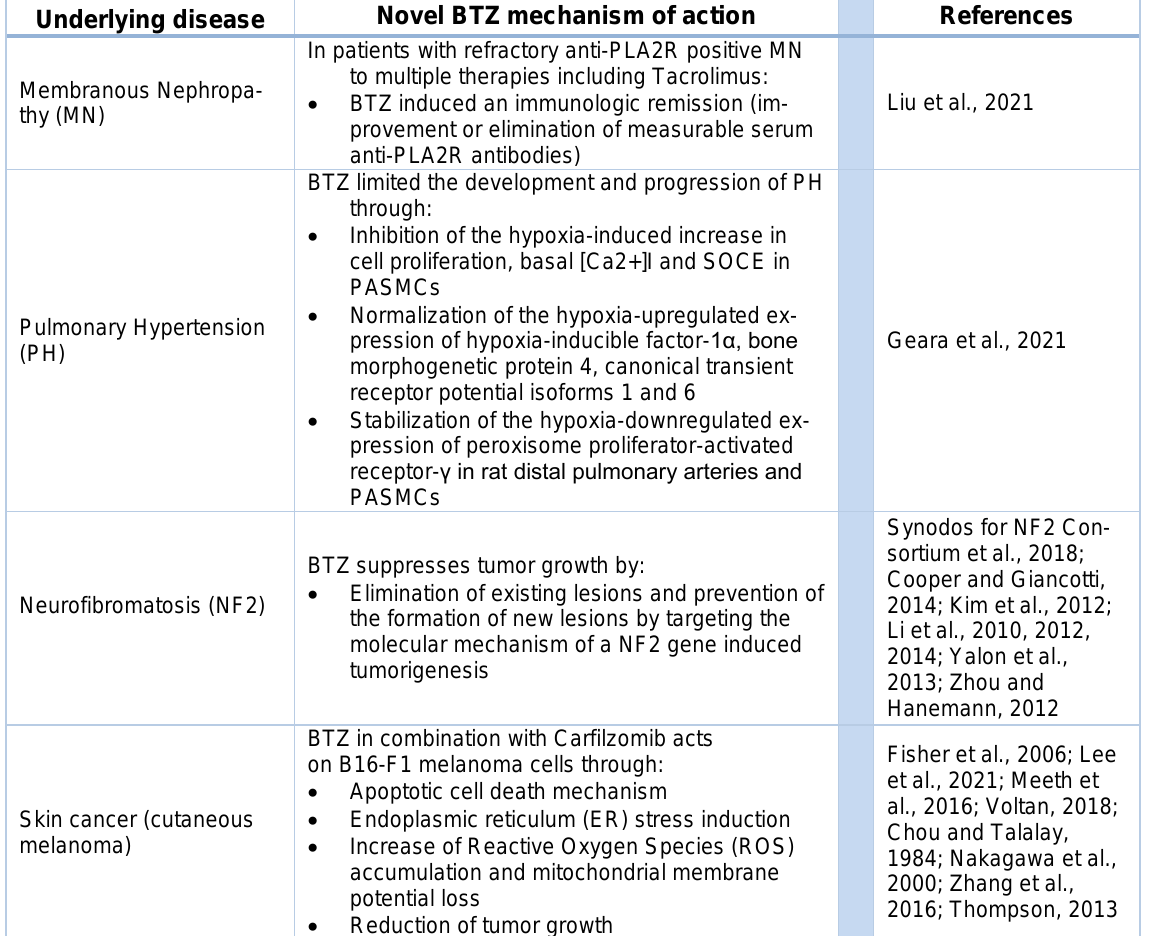
Table 2: Novel BTZ application in multiple diseases Underlying